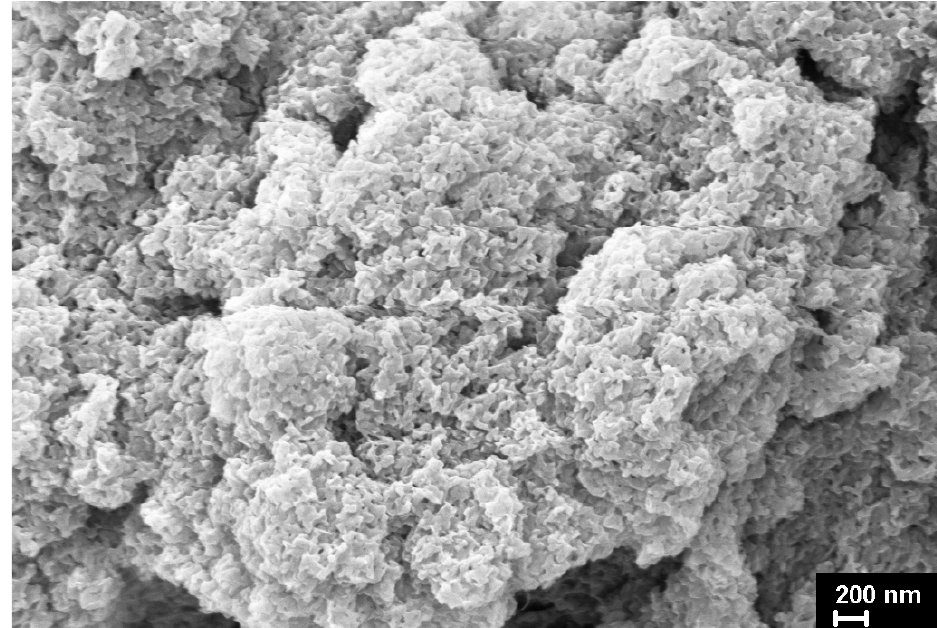
Figure 13. SEM micrograph of SC reactor powder (other location).